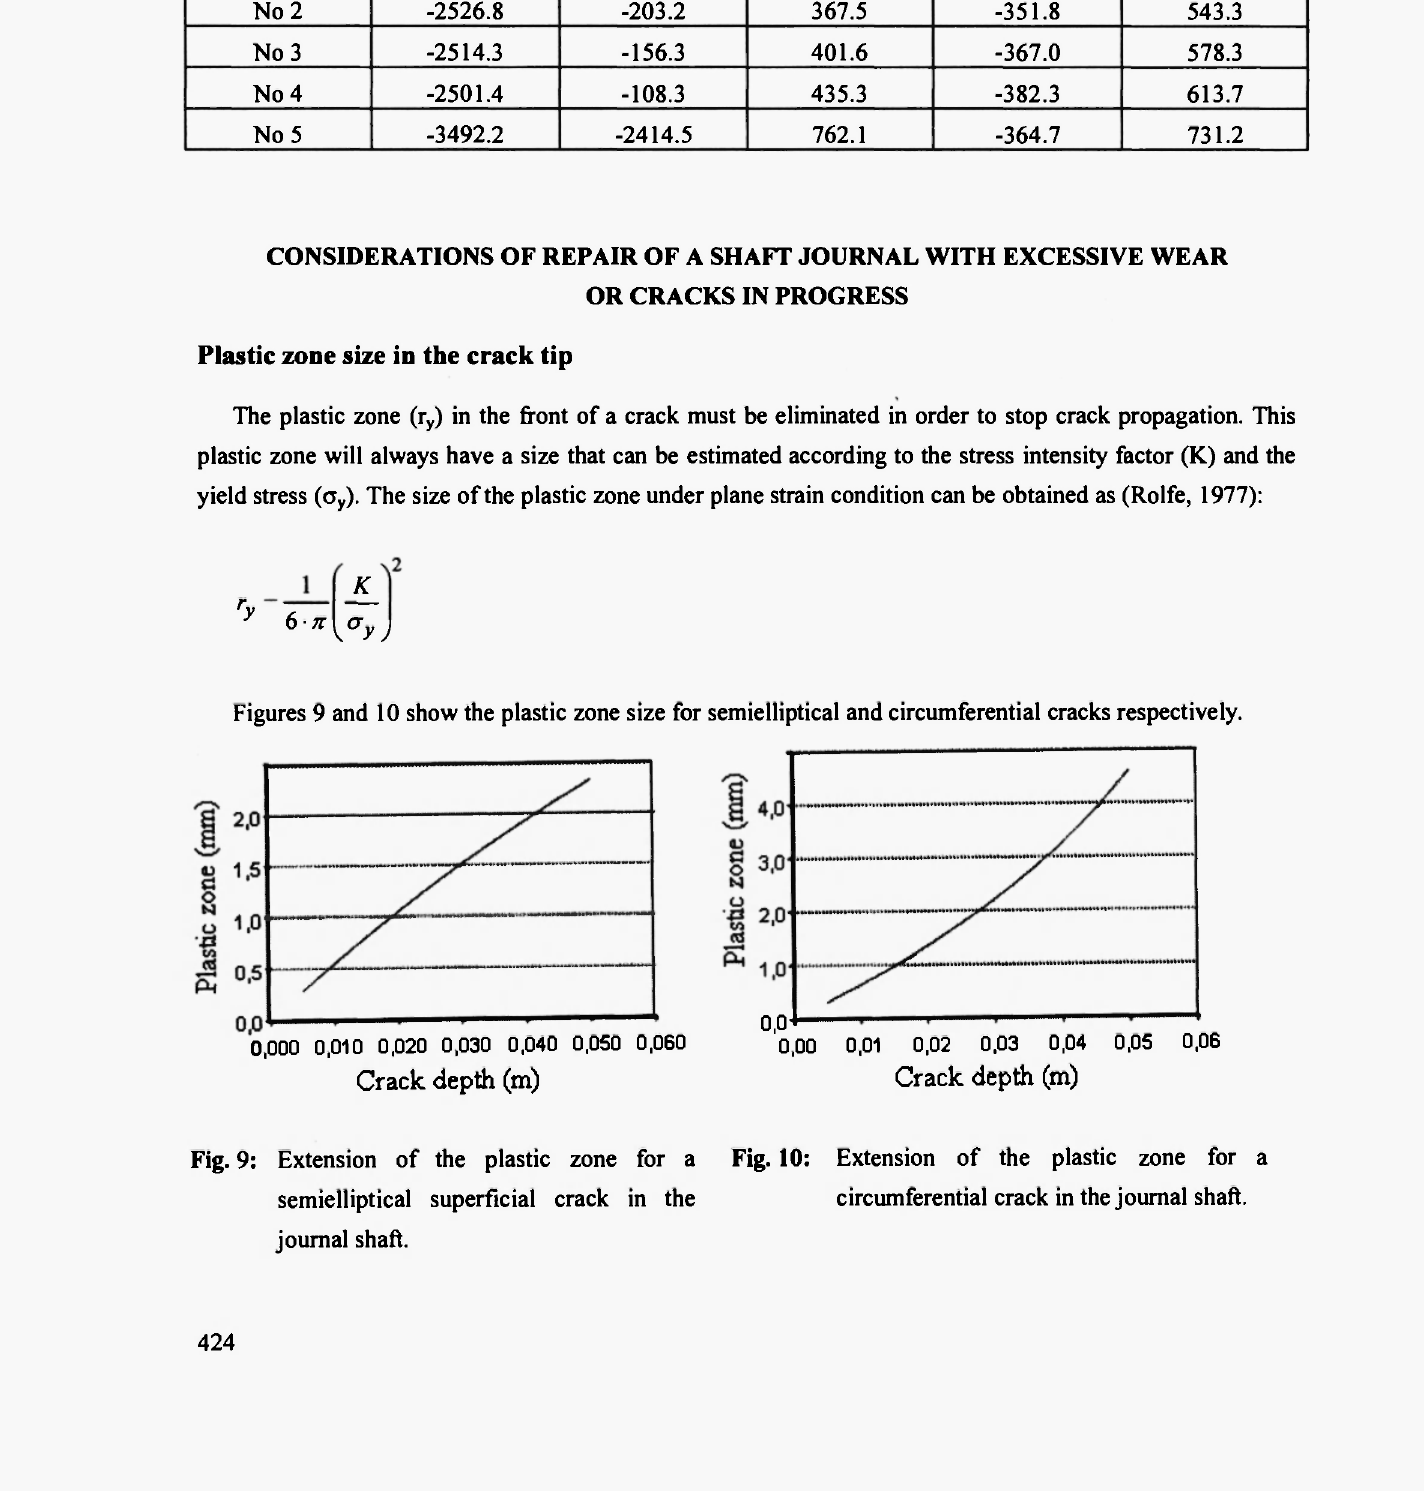
Fig. 9: Extension of the plastic zone for a semielliptical superficial crack in the journal shaft.